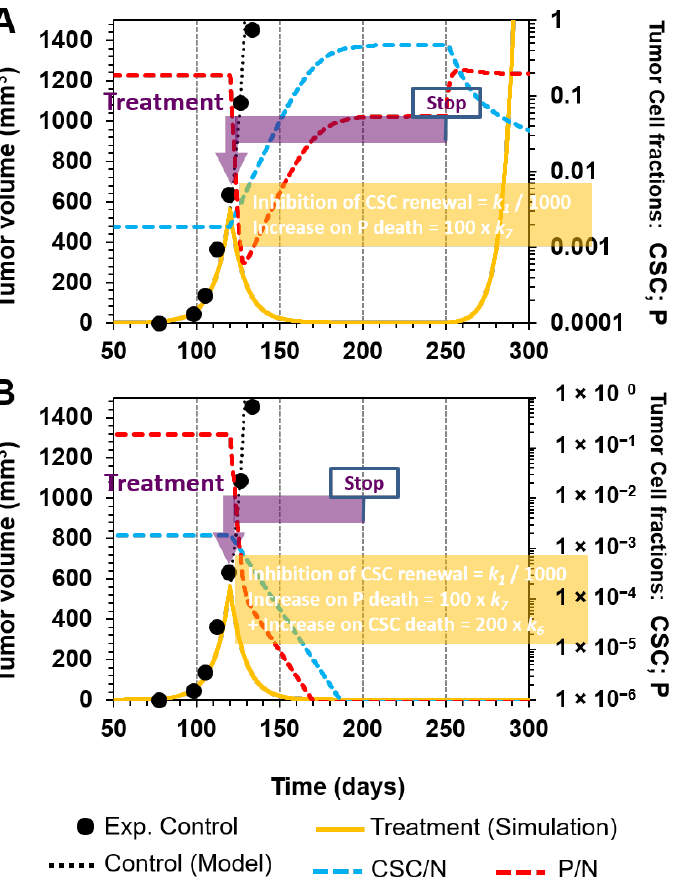
Figure 7. Time lapse for combination treatment. ( A ) When the treatment in Figure 6C (inhibition of symmetrical CSC renewal by a 1000-fold reduction in k 1 and selectively killing P cells by increasing k 7 100-fold) was selected and stopped at day 250, there was a tumor relapse at day 280 due to residual tumorigenic cells that were not eliminated when the treatment was stopped (see CSC and P cell fractions). ( B ) Selectively killing CSCs by increasing k 6 200-fold in addition to the treatment in ( A ) eradicated the tumor, which did not relapse, even when therapy was stopped at day 200. P and CSC tumor fractions are represented by dashed red and blue lines, respectively.